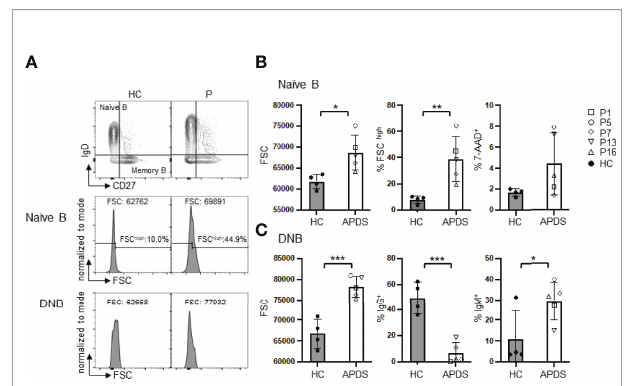
FIGURE 2 | Both naïve B and DNB cells from the patients have larger sizes than those from HC. (A) Representative FACS pro fi les of FSC in gated naïve B and DNB cells. (B) FSC (left), % FSC high (middle) and % 7-AAD + (right) cells in naïve B cells of HC and the patients. (C) Left, FSC of DNB in HC and the patients. Middle and right, proportions of IgG + and IgM + cells among the total DNB cells. Grey column, HC (n=4); Open column, patient (n=5). * p <